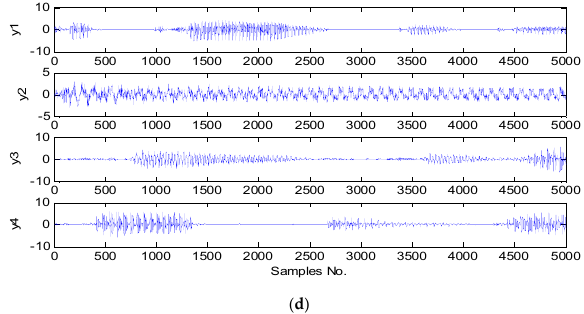
Figure 4. Comparison of ICA results using INFOMAX algorithm and optimization on the 𝐒𝐎(4) group, ( a ) source signals, ( b ) observed signals (mixed), ( c ) ICA results for the INFOMAX algorithm, ( d ) ICA results for the algorithm on the group 𝐒𝐎(4) .